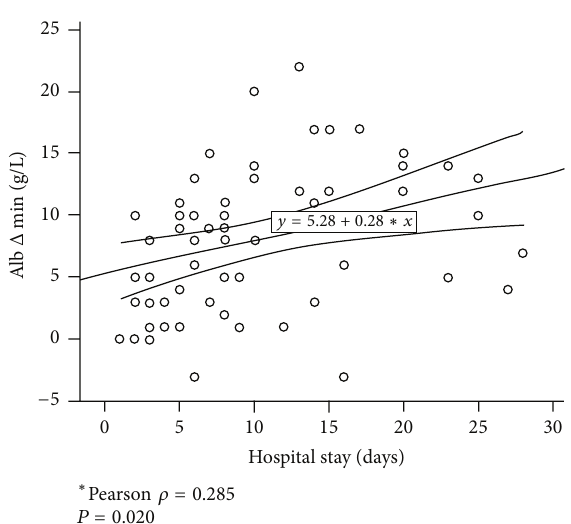
Figure 5: Albumin drop and hospital stay. Alb Δ min shows a positive correlation with increased length of hospital stay (Pearson 𝜌 = 0.285 , 𝑃 = 0.02